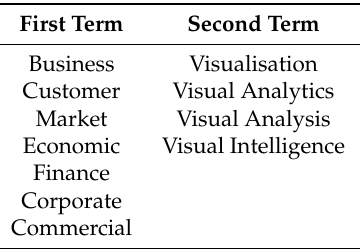
Table 2. Using the AND operator, we combined First and Second terms in the search process to produce the first list of relevant